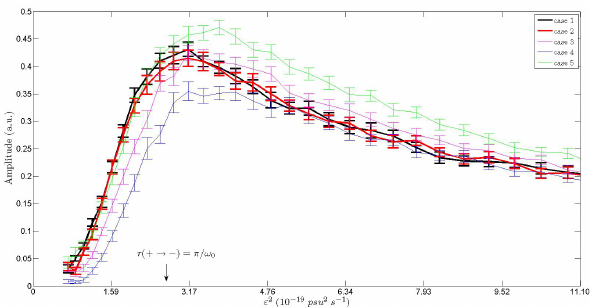
Fig. 10. Response to linear periodic perturbation as a function of the background noise for five experimental settings. Case 1 and 2 are indicative of stochastic resonance. The value of noise realising the approximate matching condition r( +→− ) = r( −→+ ) = π/ω 0 is